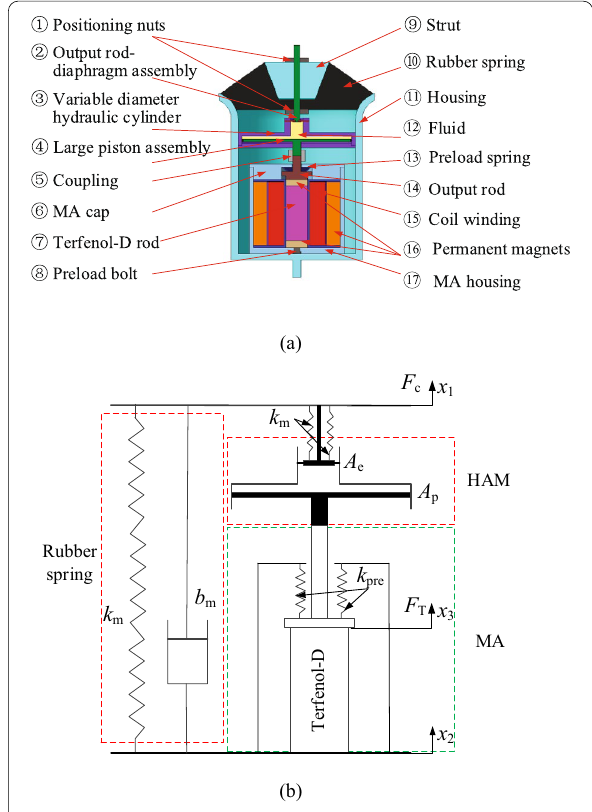
Figure 2 The proposed active mount: a configuration and b